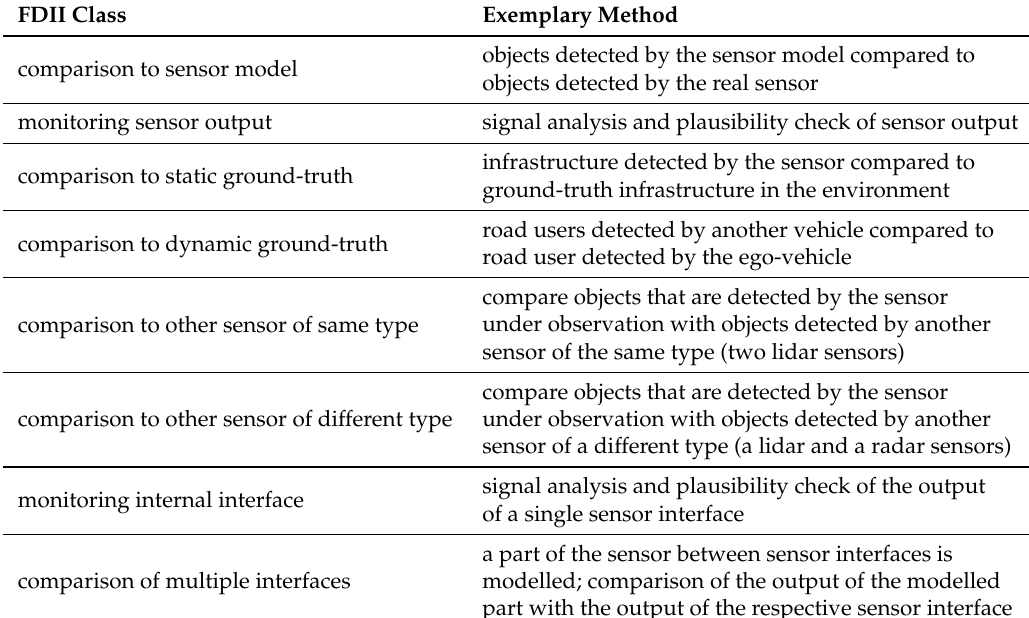
Table 2. Classification of FDII methods for perception sensors including exemplary